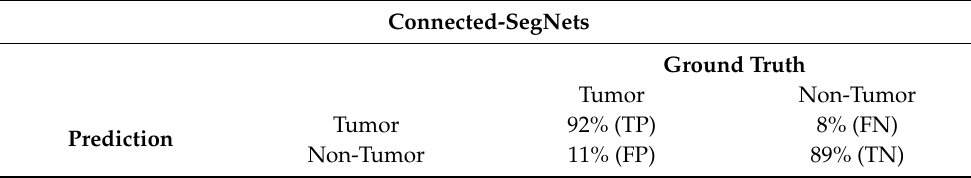
Table 6. Confusion matrix results of the proposed Connected-SegNets on the private